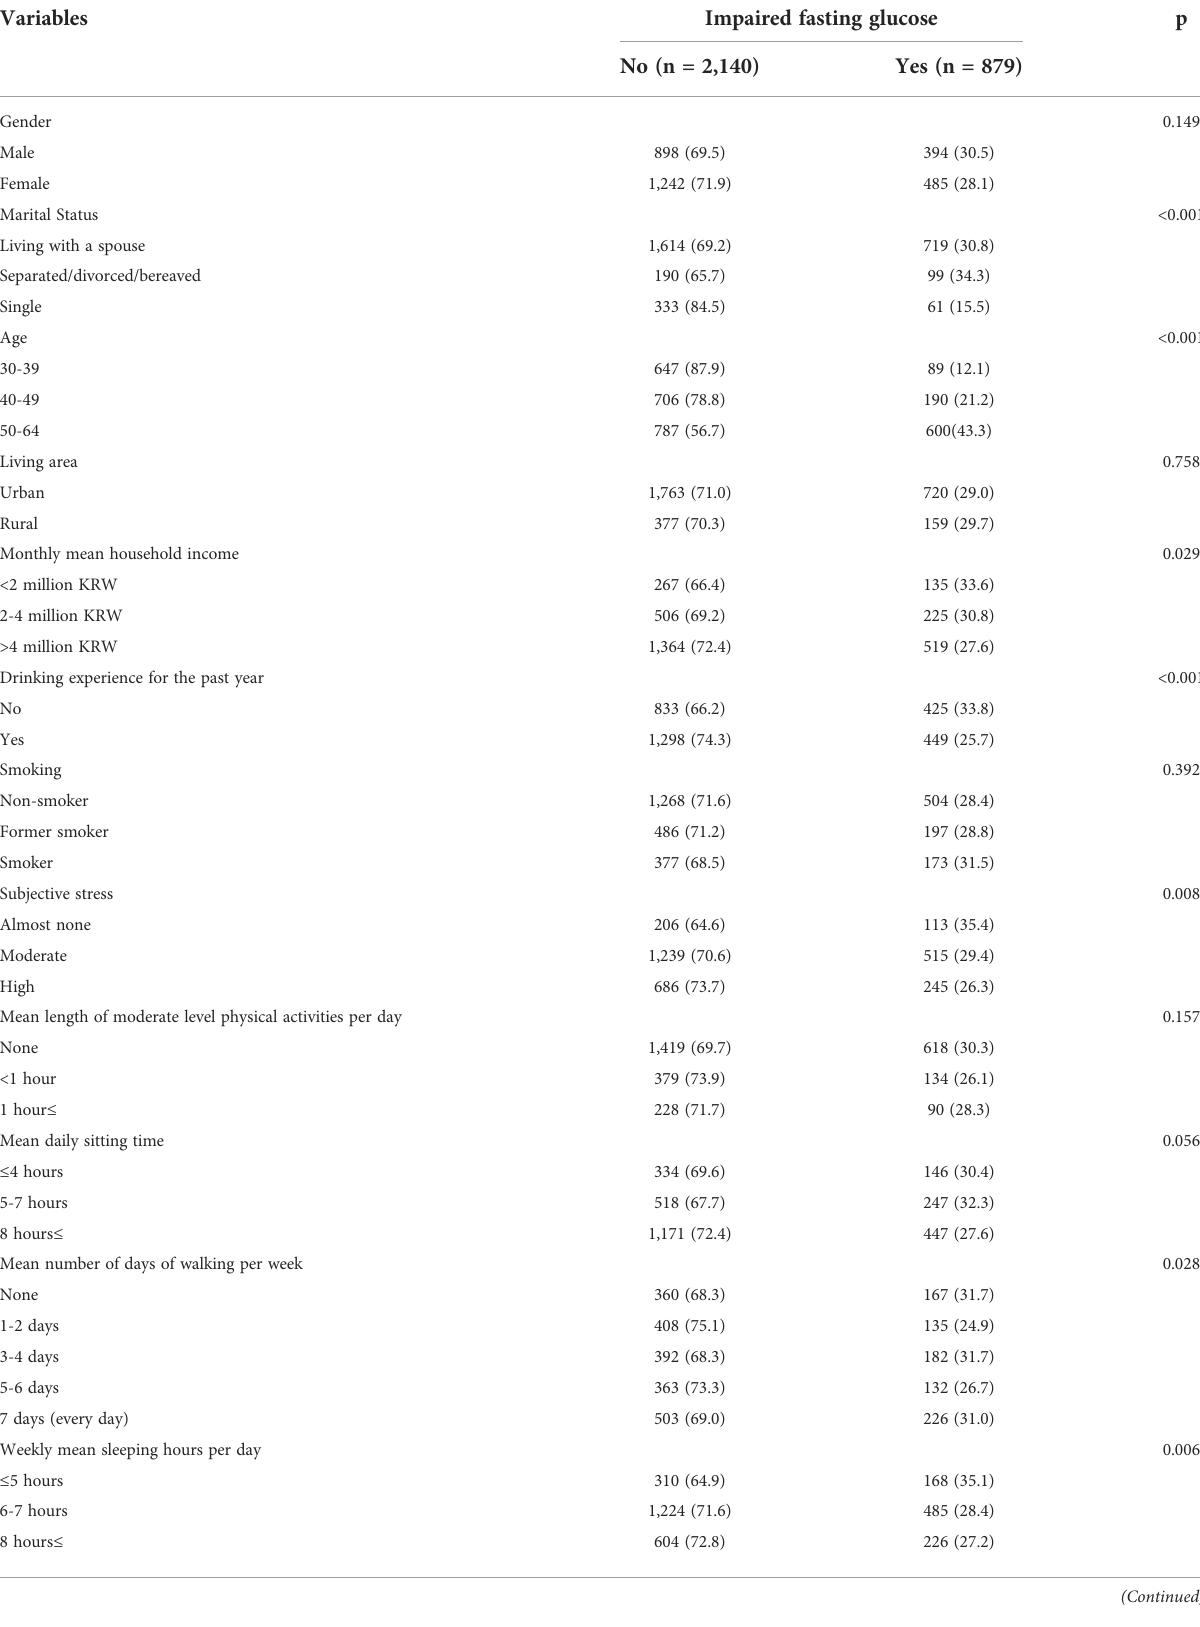
TABLE 1 General characteristics of subjects according to the prevalence of impaired fasting glucose (n,